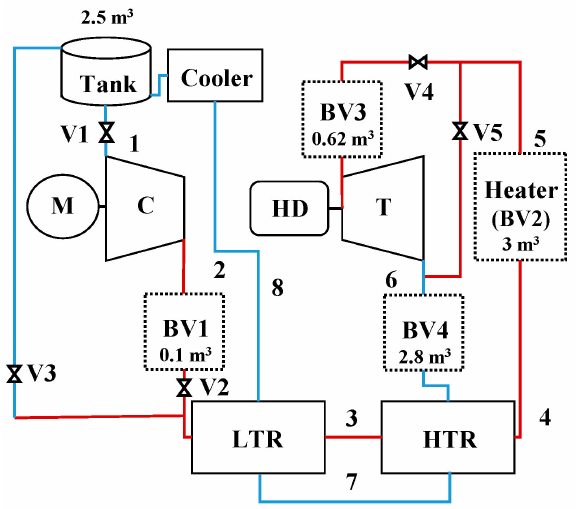
Figure 3. System model